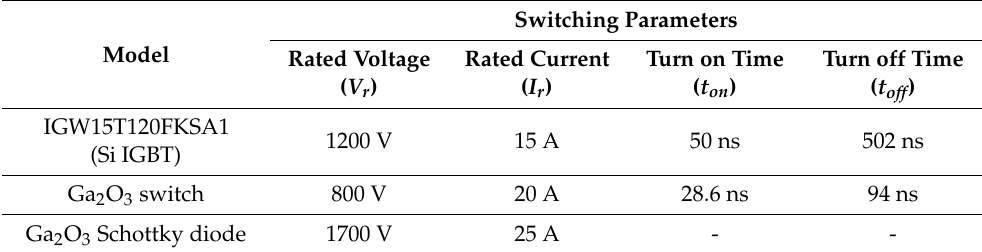
Table 4. Switching parameters of Si and Ga 2 O 3